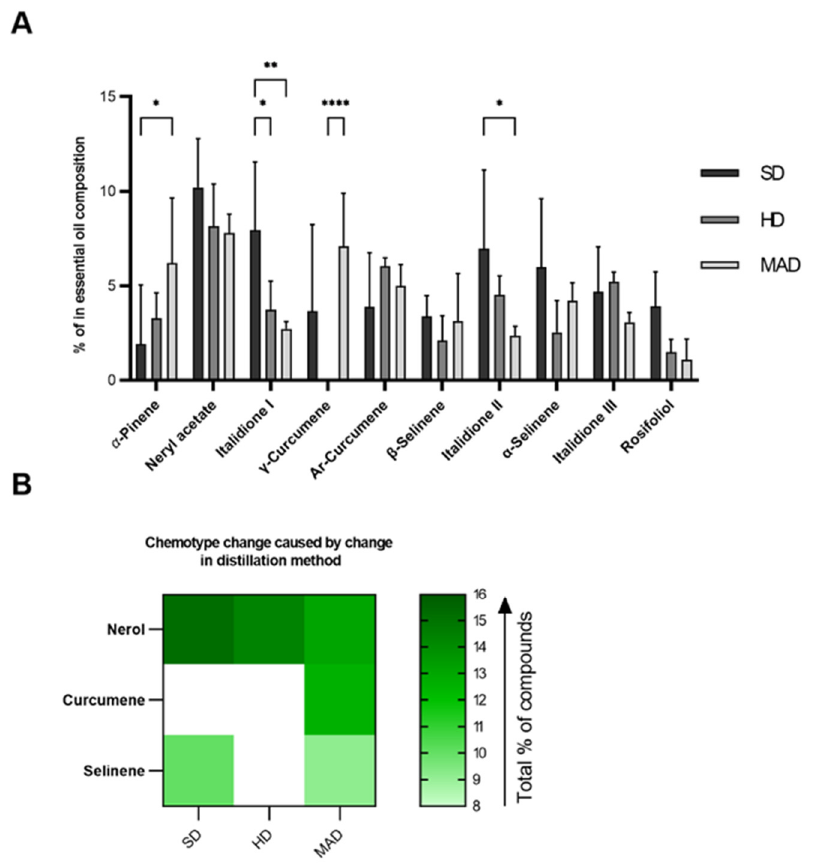
Figure 2. Application of three different distillation methods (SD—steam distillation, HD—hydrodistillation and MAD—microwave-assisted distillation) produces EOs with different compositions and chemotype. ( A ) Compounds identified in at least one sample in a proportion greater than 5%, ( B ) Heat map of total amount of nerol, curcumene and selinene compounds identified in EOs for each distillation method used. * p < 0.05, ** for p < 0.001, *** for p < 0.0001, and **** for p <